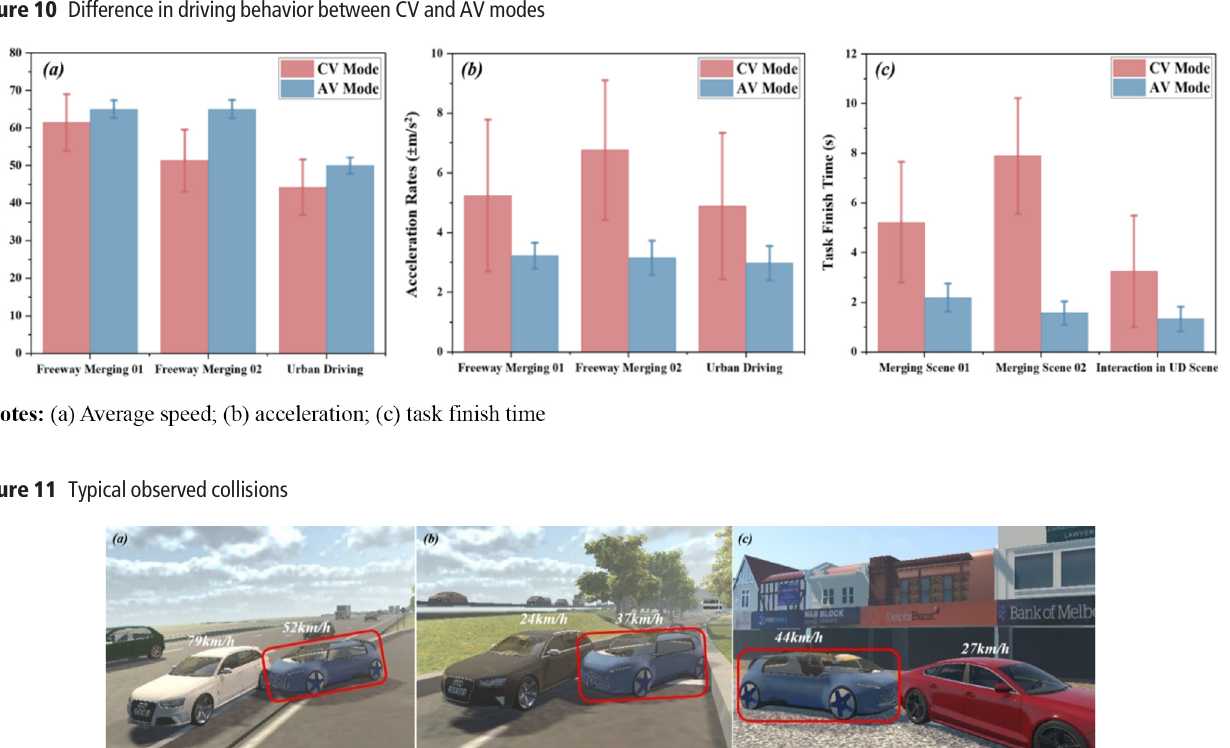
Figure 10 Difference in driving behavior between CV and AV modes